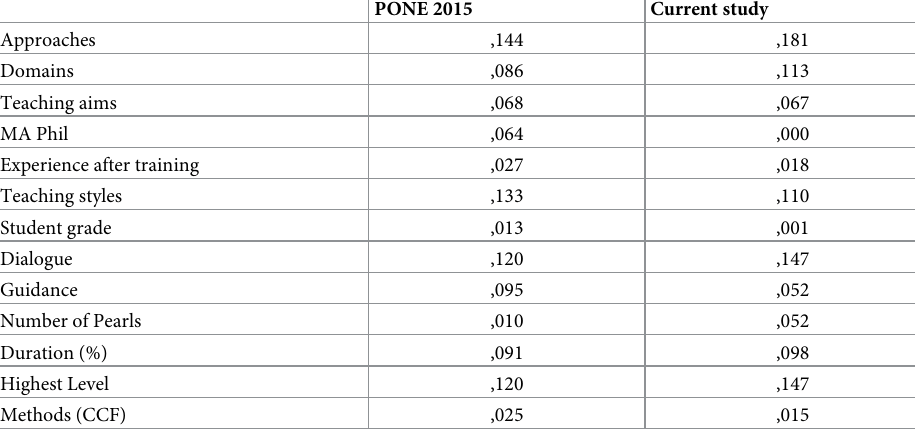
Table 2. Contributions of the variables to the first dimension of the correspondence analysis